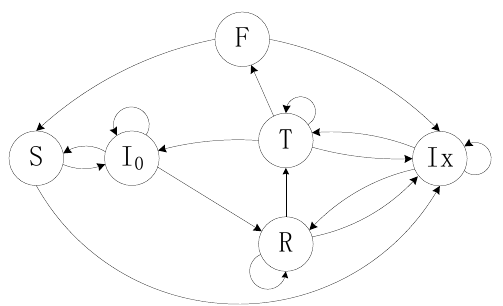
Figure 6. State transition diagram of a node in T-CDSA.